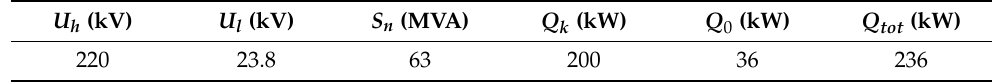
Table 3. Referent power substation data.